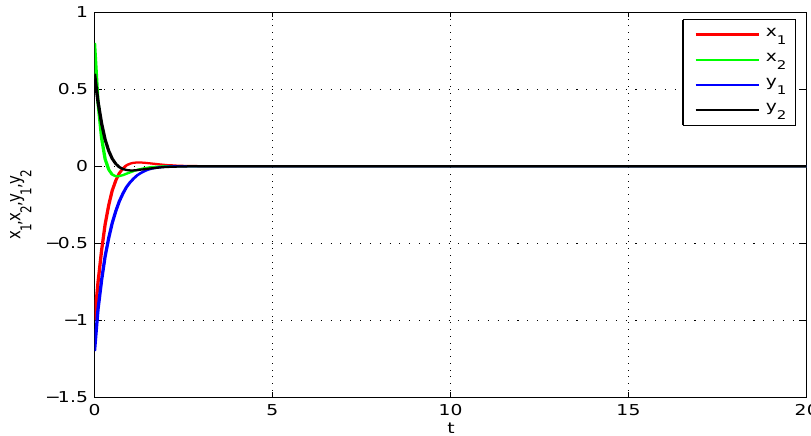
Figure 10. An illustration of the time responses with respect to the real and imaginary parts of the states p 1 and p 2 pertaining to the model in (13) in a 2 D space, in which ˜ u ( t ) = 0 in Example